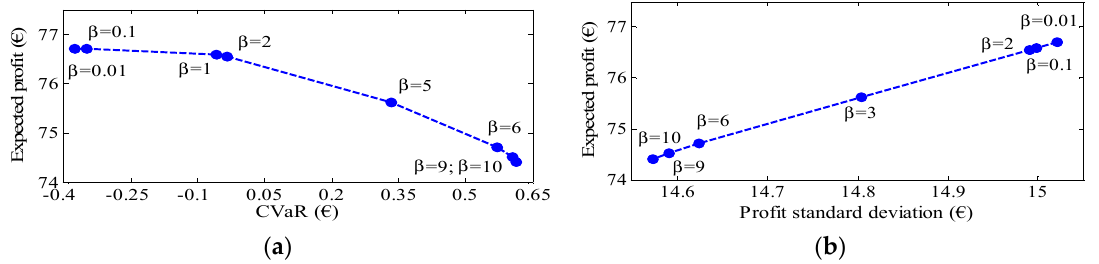
Figure 4. Expected profit versus ( a ) CVaR; ( b ) average of standard deviation of the profit for different values of β .